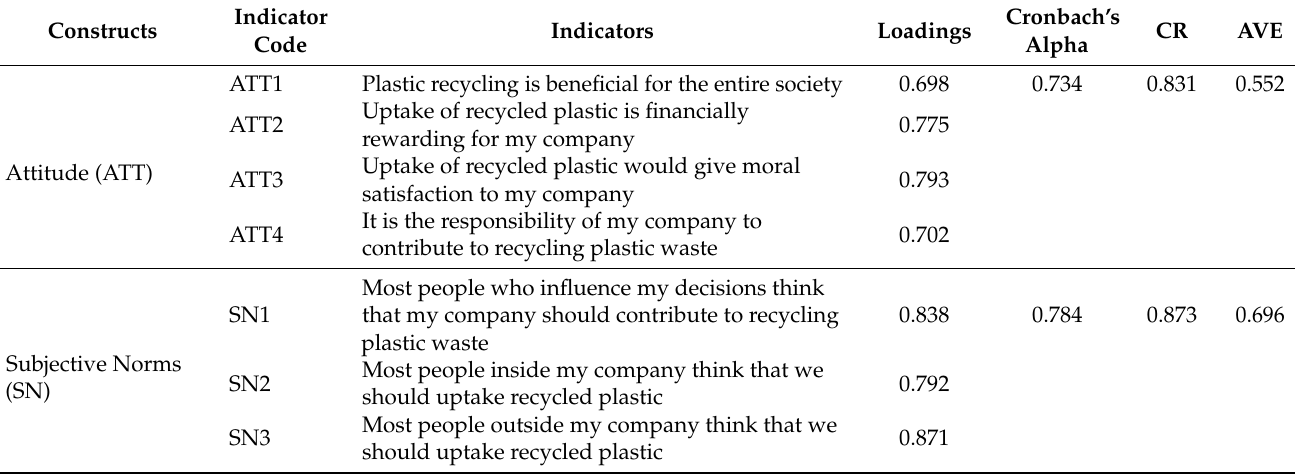
Table 2. Measurement model reliability and